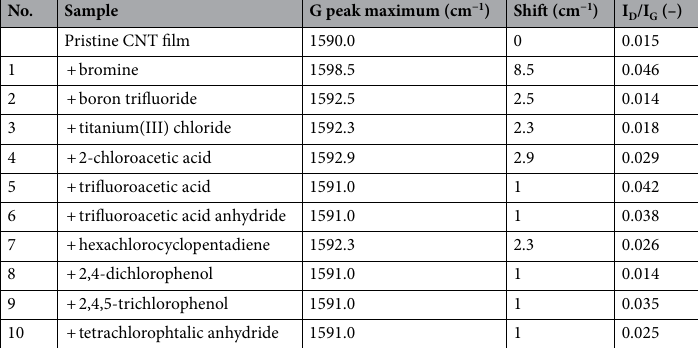
Table 1. Analysis of doped CNT films by Raman